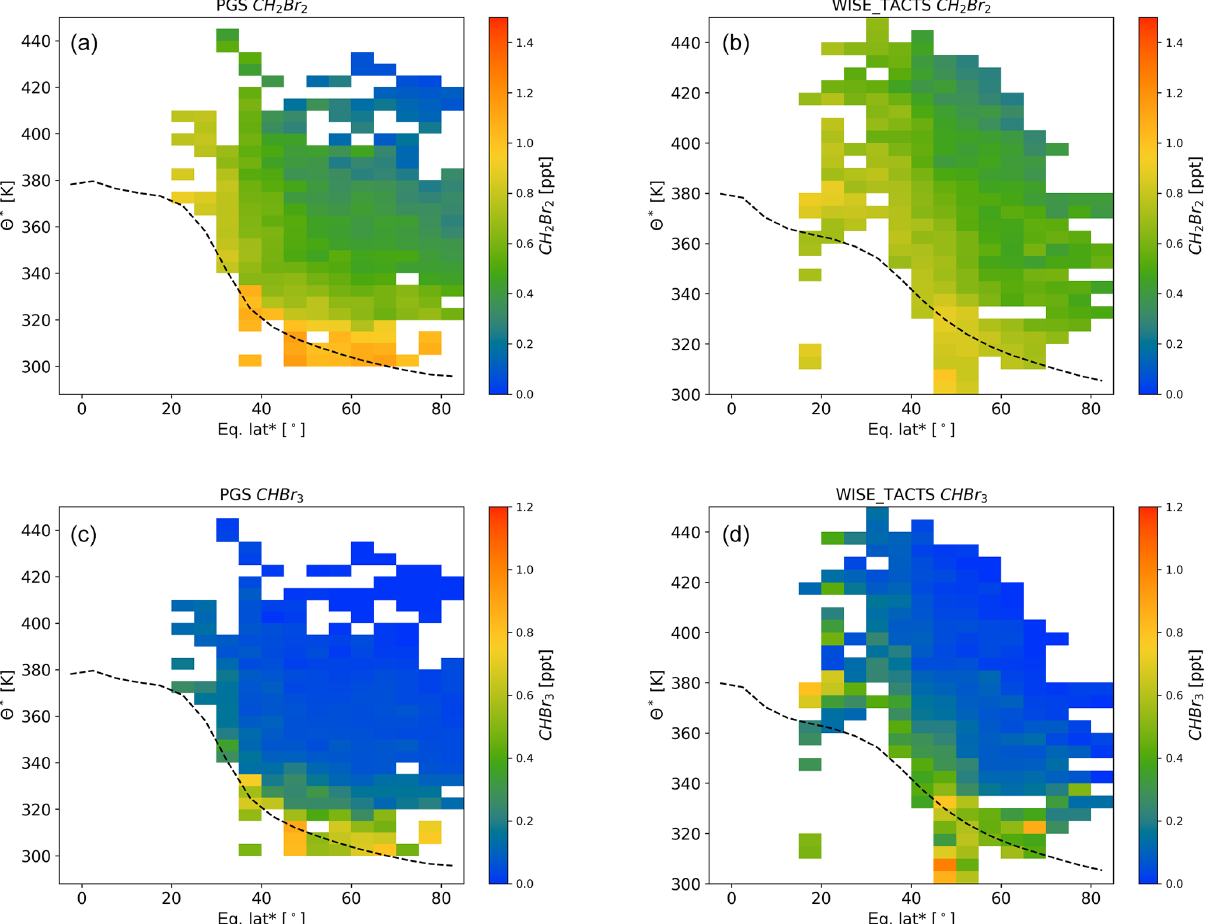
Figure 5. Altitude–latitude cross sections of CH 2 Br 2 (a, b) and CHBr 3 (c, d) compiled from all flights during the PGS campaign from late December 2015 to March 2016 (a, c) and the TACTS WISE campaigns representative of conditions in late summer to early fall (b, d) . The data are displayed as a function of θ ∗ (see description in Sect. 2) and equivalent latitude ∗ . The dynamical tropopause (dashed line) has been derived from the ERA-Interim reanalysis, providing a climatological mean zonal mean value of the